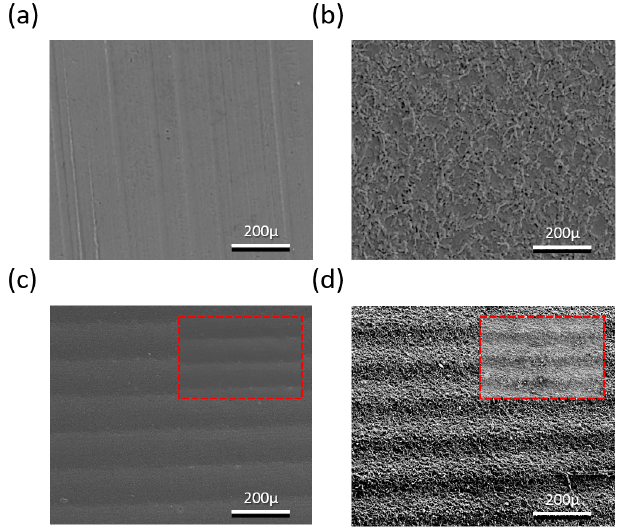
Figure 3. Scanning electron microscope (SEM) images of four samples of the Cu current collector: ( a ) bare Cu current collector; ( b ) laser-ablated Cu current collector; ( c ) imprinted Cu current collector; ( d ) laser + imprinted Cu current collector.